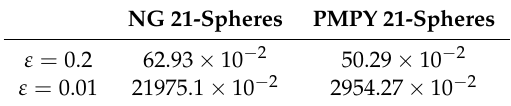
Table 3. Energy dissipation E ( γ ) of 20-arms NG and PMPY types of